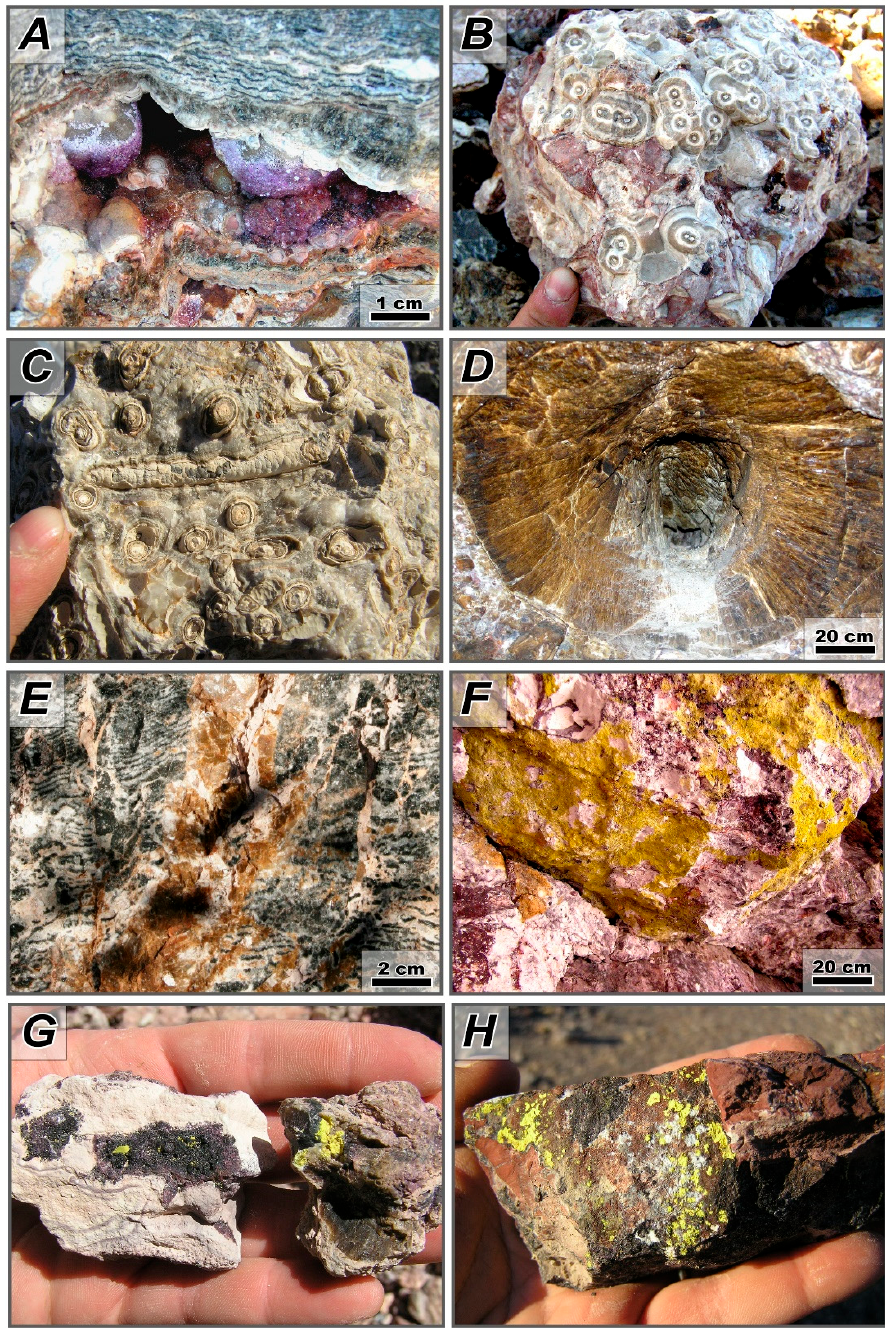
Figure 4. Macroscopic arrangement of MVT-like fluorite ( A to E ) and later fluorite-U-V-Mo-P mineralisation ( F to H ) in the Aguachile–Cuatro Palmas area, Coahuila. ( A ) Zebra-like fluorite mineralisation and purplish euhedral fluorite lining cavities; La Fácil deposit. ( B and C ) Stalactitic growths of pure fluorite, brecciated and cemented by later fluorite; La Fácil deposit. ( D ) Large skeletal fluorite crystals in botryoidal arrangements, eventually affected by later brecciation; Las Alicias deposit. ( E ) MVT-like zebra fluorite crosscut by later hydrothermal brown fluorite and calcite; El Caracol mine. ( F ) Yellow carnotite-lined fractures within earlier MVT-like brecciated fluorite and host sedimentary rocks; Las Alicias deposit. ( G ) Hand specimens of stringers within host sedimentary rocks showing the early fluorite+carnotite association in them; Las Alicias deposit. ( H ) Hand specimen of carnotite (yellow) stringers with abundant crandallite needle-like crystals with a radial arrangement (white); Las Alicias deposit.